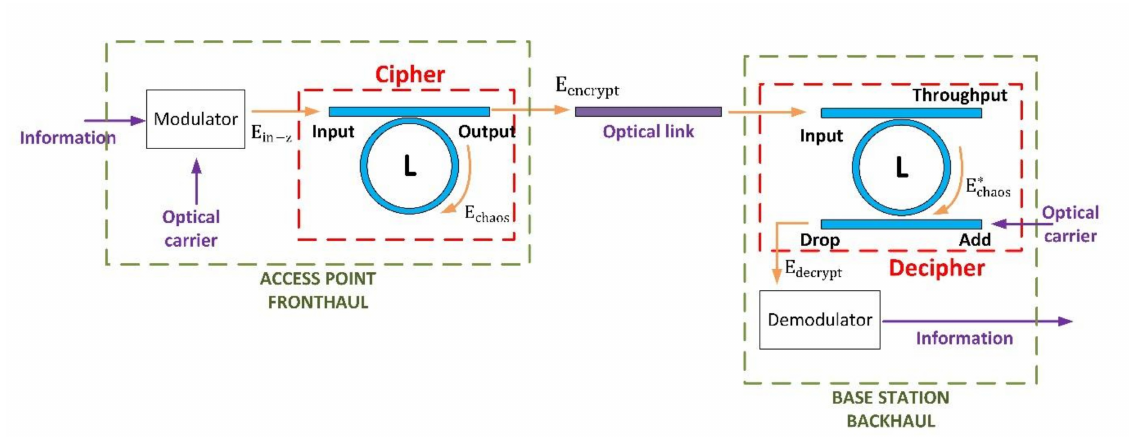
Figure 6. Proposed information protection scheme for C-RAN